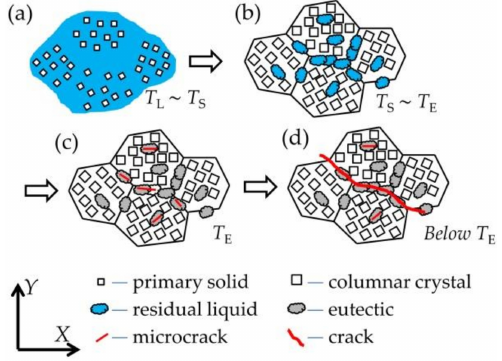
Figure 7. Schematic diagram of the formation process of solidification